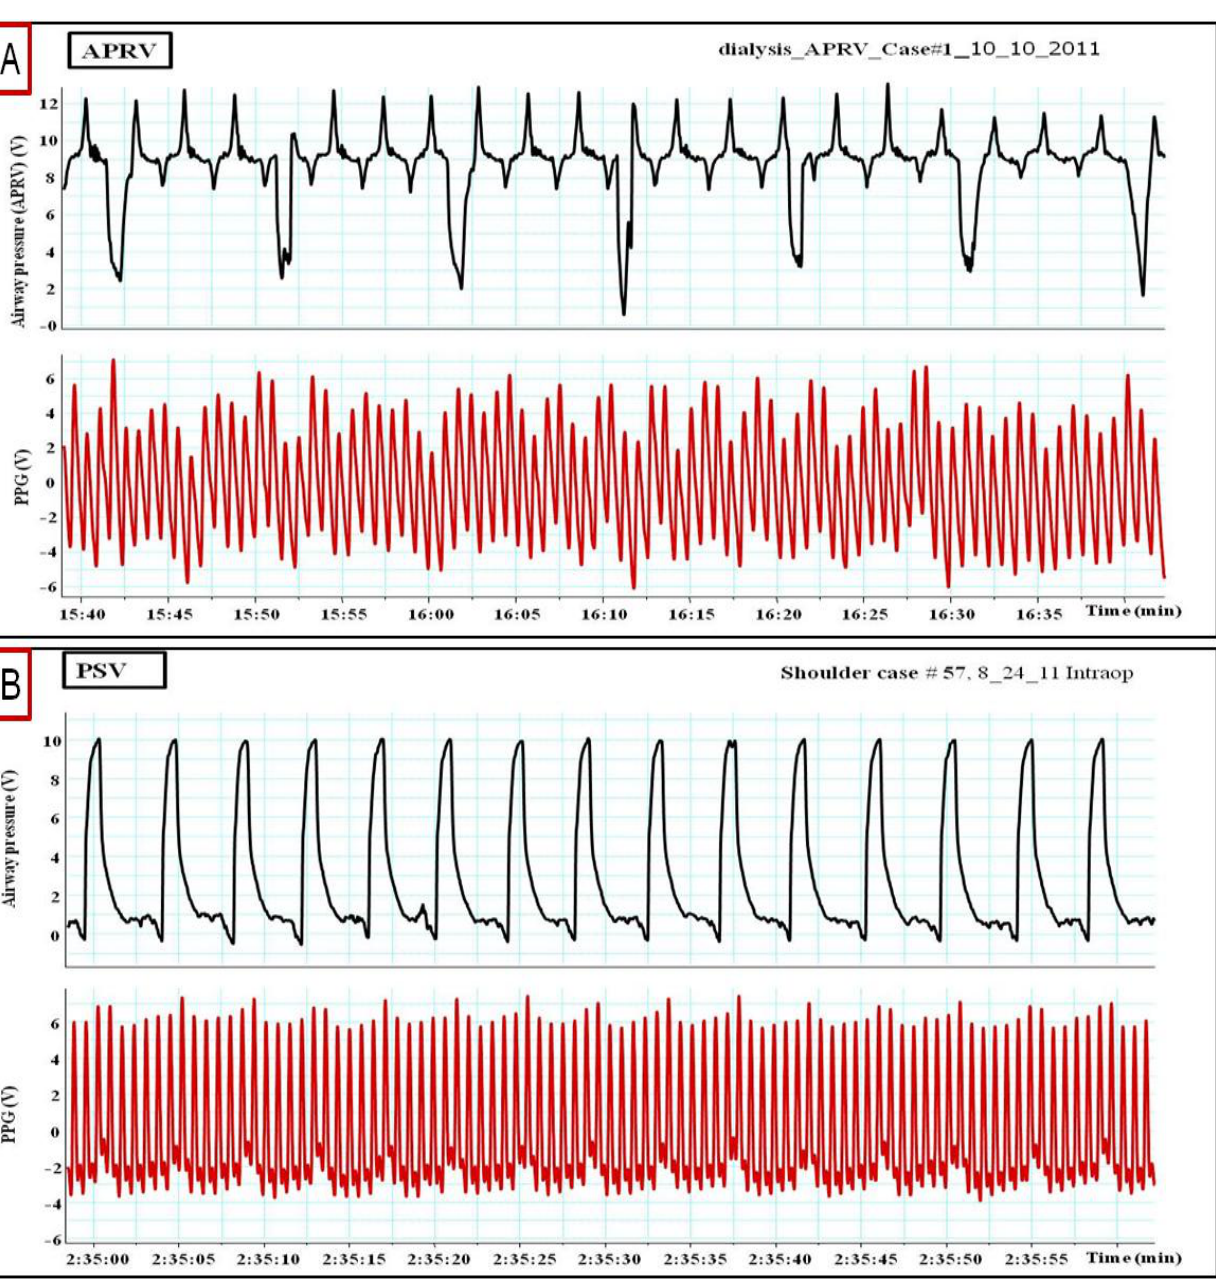
Figure 10. ( A ) Impact of Airway Pressure Release Ventilation (APRV) and ( B ) Pressure Support Ventilation (PSV pro) on peripheral venous pressure (PVP) and plethysmographic (PPG)